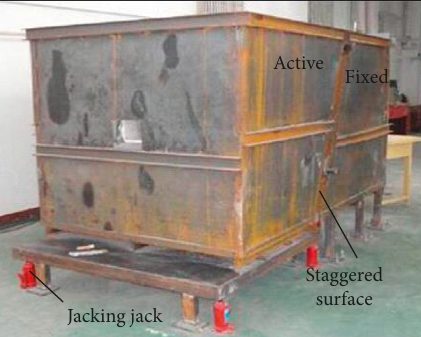
Figure 2: Leaning straight stick-slip dislocation test box.